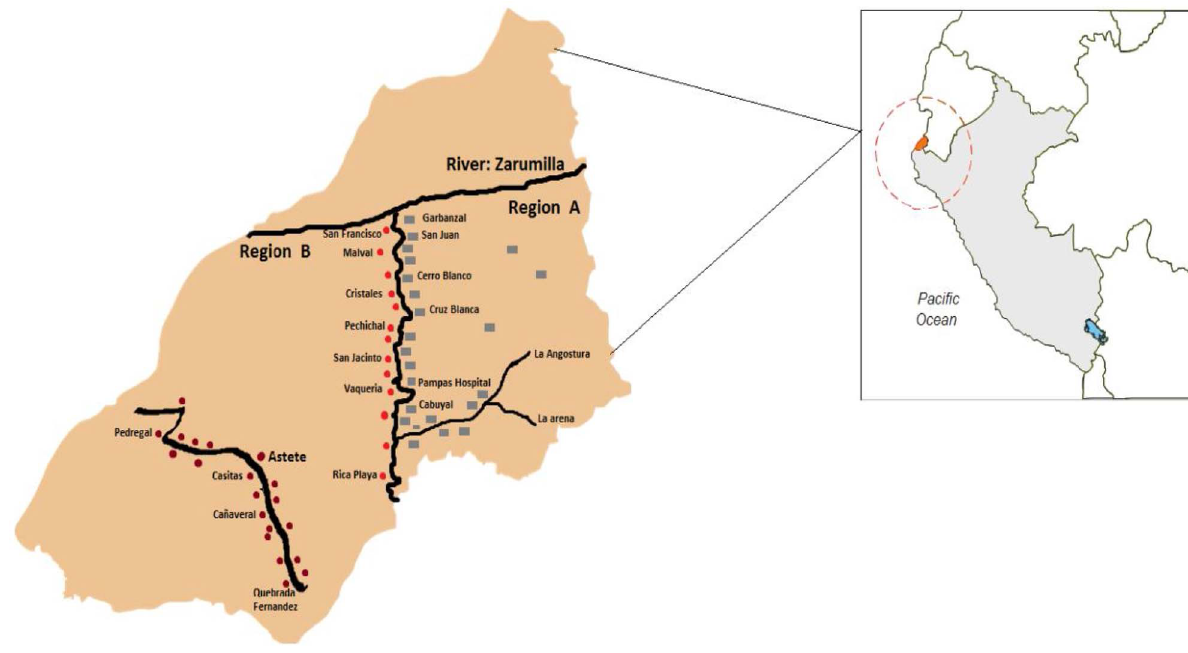
Figure 2. Study Flowchart for region A (2006) and region B (2007).